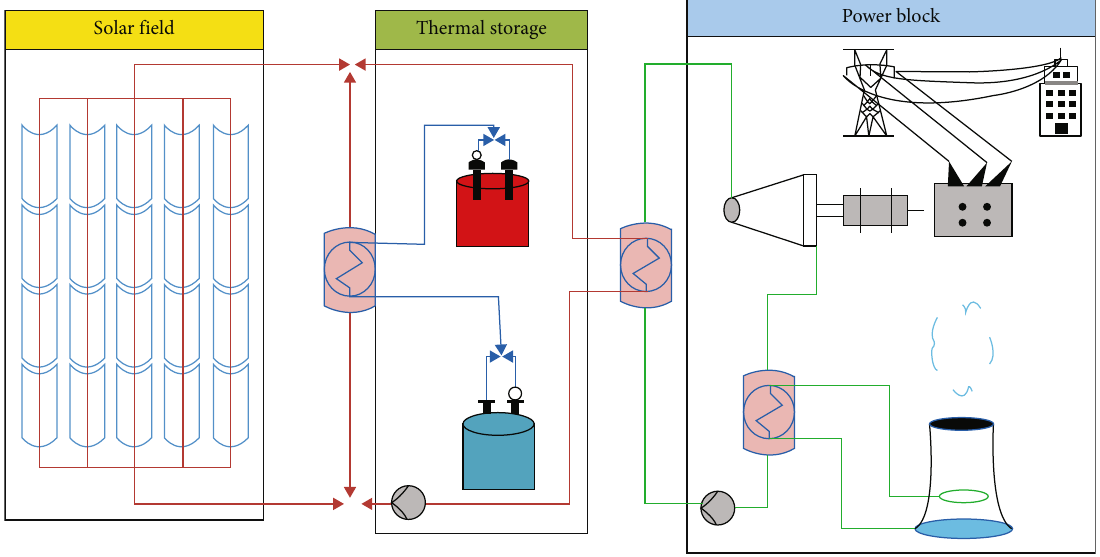
Figure 4: A physical layout of CSP plant.